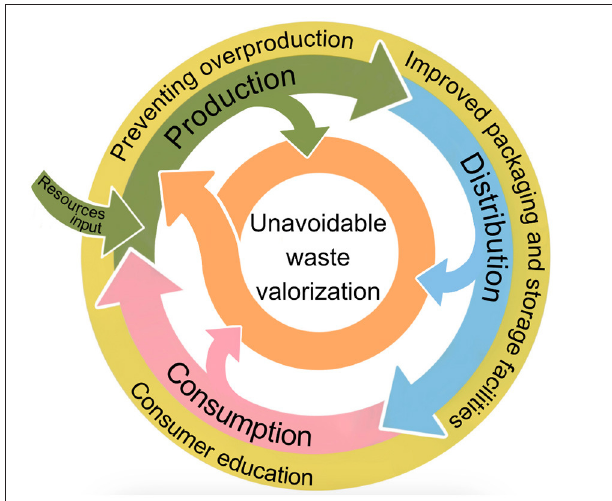
FIGURE 2 | Strategies to reduce food waste in the food supply chain in a circular food system: prevention for avoidable food waste (yellow curve) and valorization for unavoidable food waste (orange curve).